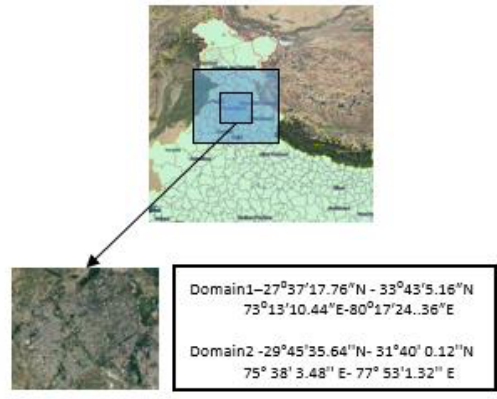
Figure 2. Domain